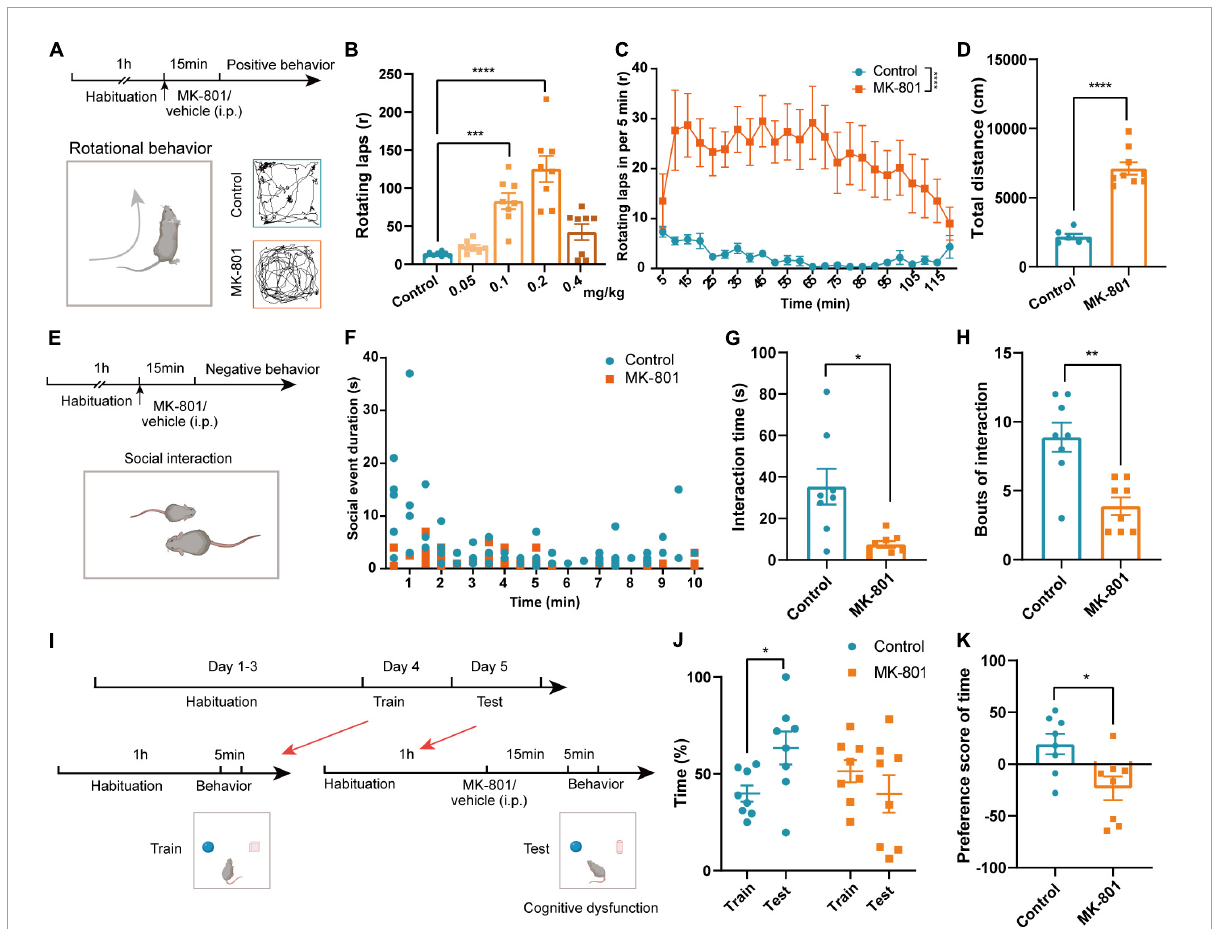
FIGURE1 MK-801 caused schizophrenia-like behaviors in mice. (A) Timeline of the behavioral tests and diagram of the rotational behavior. (B) Laps of the rotational behavior produced by the injection of different concentrations of MK-801 (Kruskal–Wallis H test, Control n = 8 mice, MK-801 0.05 mg/kg n = 8 mice, MK-801 0.1 mg/kg n = 8 mice, MK-801 0.2 mg/kg n = 8 mice, MK-801 0.4 mg/kg n = 8 mice). (C) Rotational behavior was initiated 5 min after the injection and peaked at approximately 10–15 min, and the effects lasted approximately 2 h (Friedman’s M test, Control n = 6 mice, MK-801 n = 6 mice). (D) The total distance traveled by the MK-801-treated group and control group in the open field test (OFT) (unpaired t -test, Control n = 6 mice, MK-801 n = 9 mice). (E–H) Timeline of the behavioral tests and diagram of the social interaction test (E) . The social event duration in per minute (F) , interaction time [ (G) , unpaired separate variance estimation t -test] and bouts of the interaction [ (H) , Mann–Whitney U test] of MK-801-injected mice and control mice (Control n = 8 mice, MK-801 n = 8 mice). (I–K) Timeline of the behavioral tests and diagram of the novel object recognition (NOR) test (I) . The time spent with novel objects [ (J) , paired t -test/Wilcoxon signed-rank test] and the preference score [ (K) , unpaired t -test] of MK-801-injected mice and control mice (Control n = 8 mice, MK-801 n = 8 mice). Data are shown as the means ± SEM. *Indicates a significant difference between groups. * p < 0.05, ** p < 0.01, *** p < 0.001, and **** p <